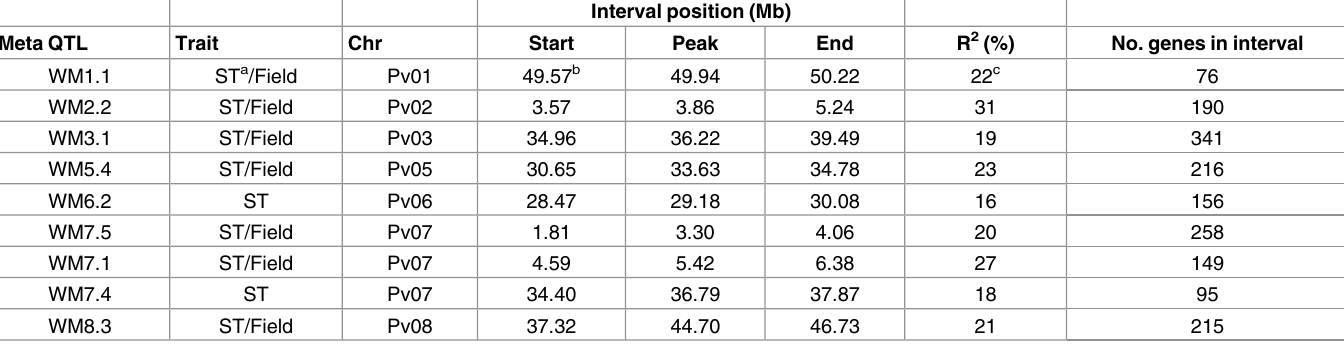
Table 3. Common bean white mold meta-QTL. The results are basedon a meta-analysis of 37 QTL identified across 14 RIL populations and positioned rel- ative to the Stampede x Red Hawk reference map [11].